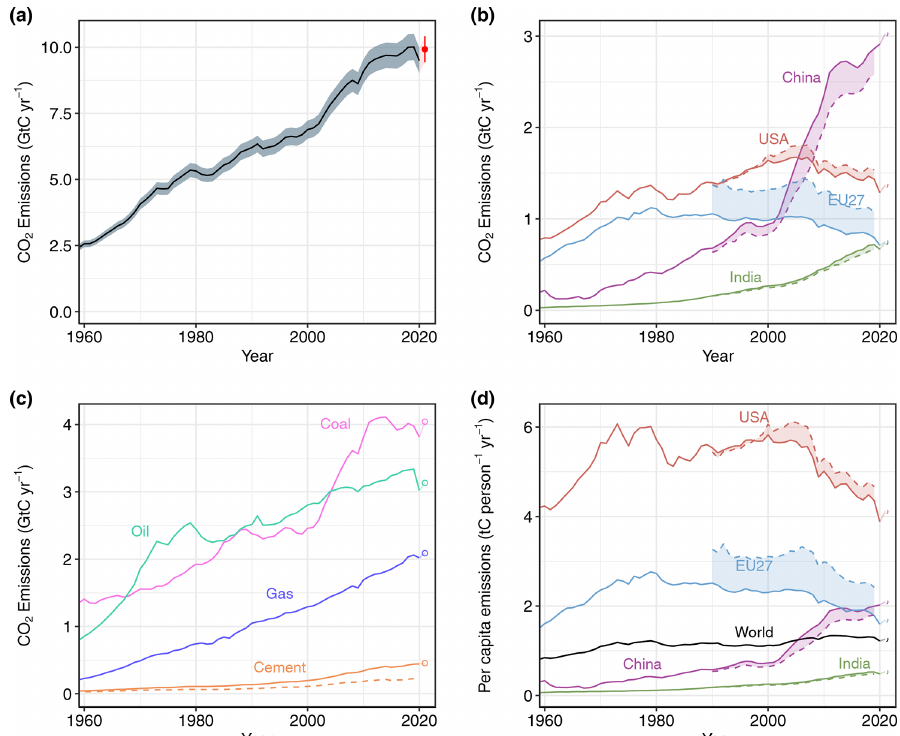
Figure 5. Fossil CO 2 emissions for (a) the globe, including an uncertainty of ± 5% (grey shading) and a projection through the year 2021 (red dot and uncertainty range); (b) territorial (solid lines) and consumption (dashed lines) emissions for the top three country emitters (USA, China, India) and for the European Union (EU27); (c) global emissions by fuel type, including coal, oil, gas, and cement, and cement minus cement carbonation (dashed); and (d) per capita emissions the world and for the large emitters as in panel (b) . Territorial emissions are primarily from Gilfillan and Marland (2021) except national data for the USA and EU27 for 1990–2018, which are reported by the countries to the UNFCCC as detailed in the text; consumption-based emissions are updated from Peters et al. (2011b). See Sect. 2.1 and Appendix C1 for details of the calculations and data